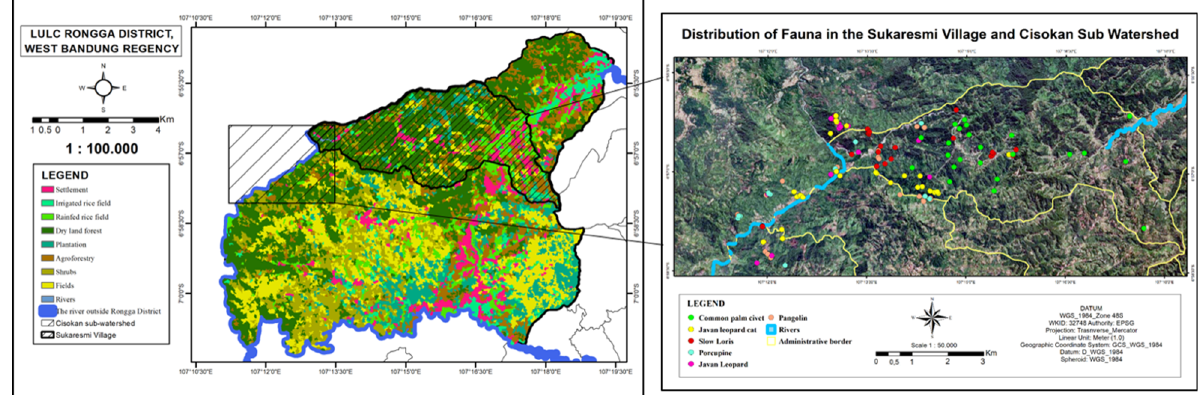
Figure 6. Land use and distribution of fauna in Rongga Sub-district.